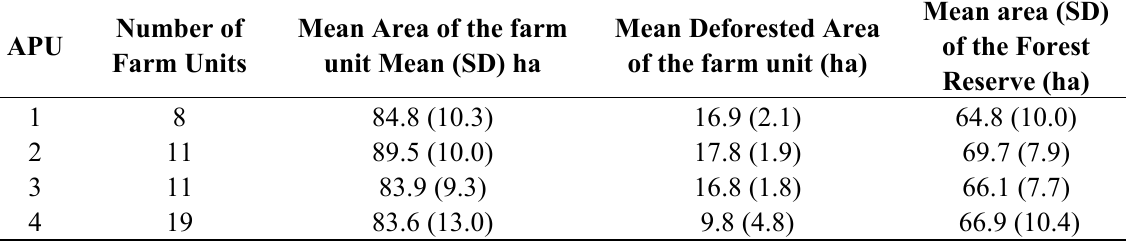
Table 1. Main characteristics of the farms in the Moju